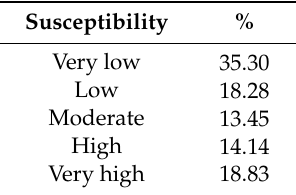
Figure 9. Landslide susceptibility map derived from logistic regression with inset plots highlighting two hazardous portions of the Karnali highway. Table 4. Percentage of landslide susceptibility classes in the study area.